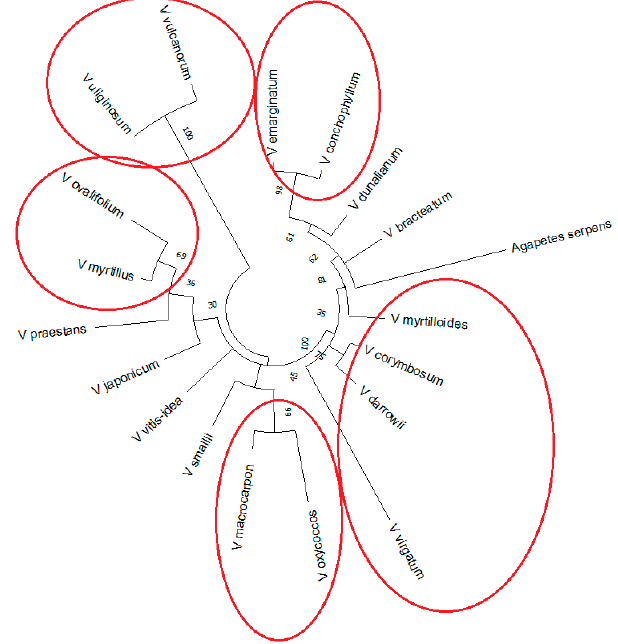
Figure 5. Molecular phylogenetic analysis of Vaccinium based on the rolB/C -like gene using Maximum Likelihood method and General Time Reversible model (There were a total of 667 positions in the final dataset). Representatives of the same section are circled in ovals.